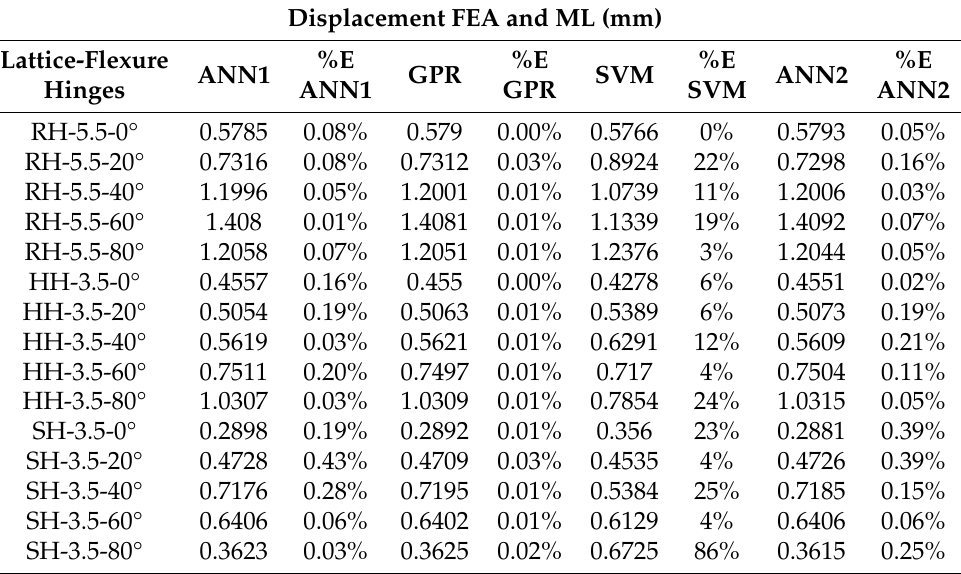
Table 2. Displacement prediction errors (%E) between FEA and ML